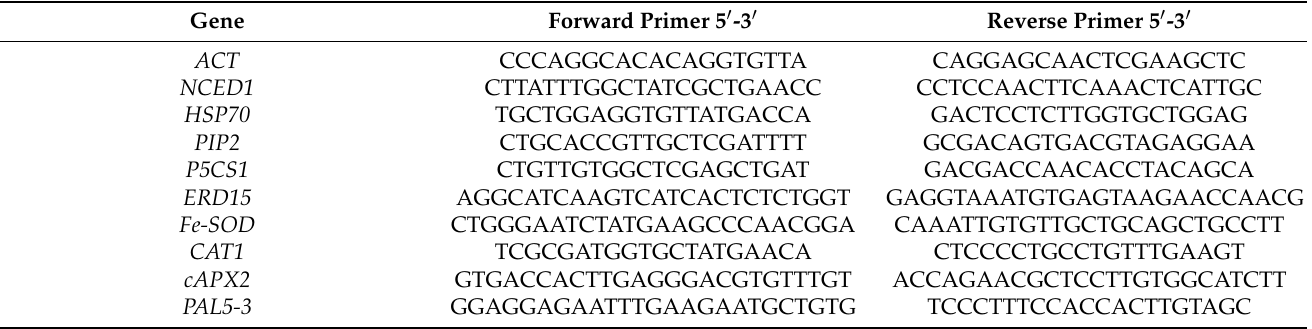
Table 4. Primer sequences of the analyzed